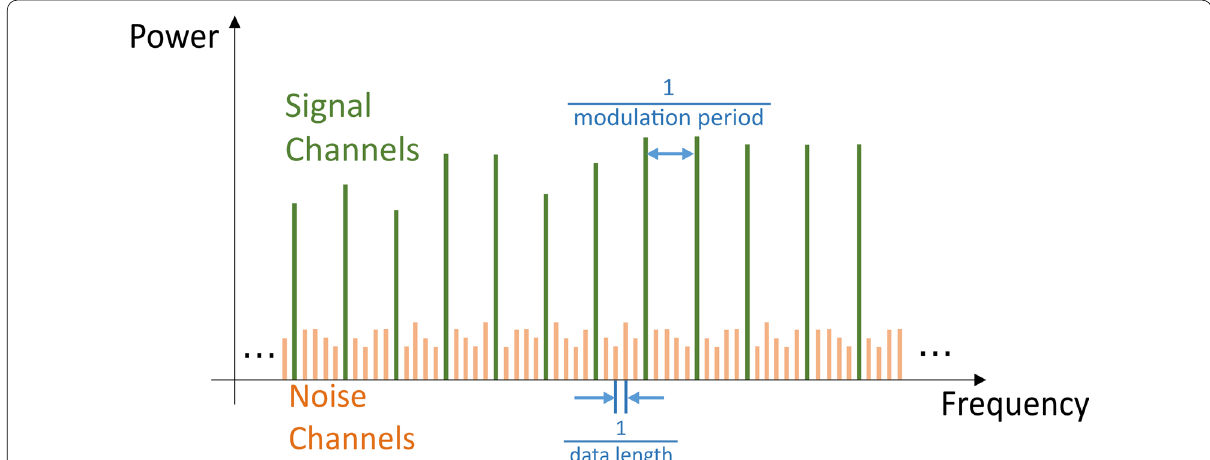
Fig. 1 Characteristics of the ACROSS signal in frequency domain. Typical distributions of the signal channels and noise channels in the frequency domain are illustrated. The signal channels appear at a constant interval, and noise channels appear in between. The intervals for the signal and noise channels are reciprocal of the modulation period and the data length,